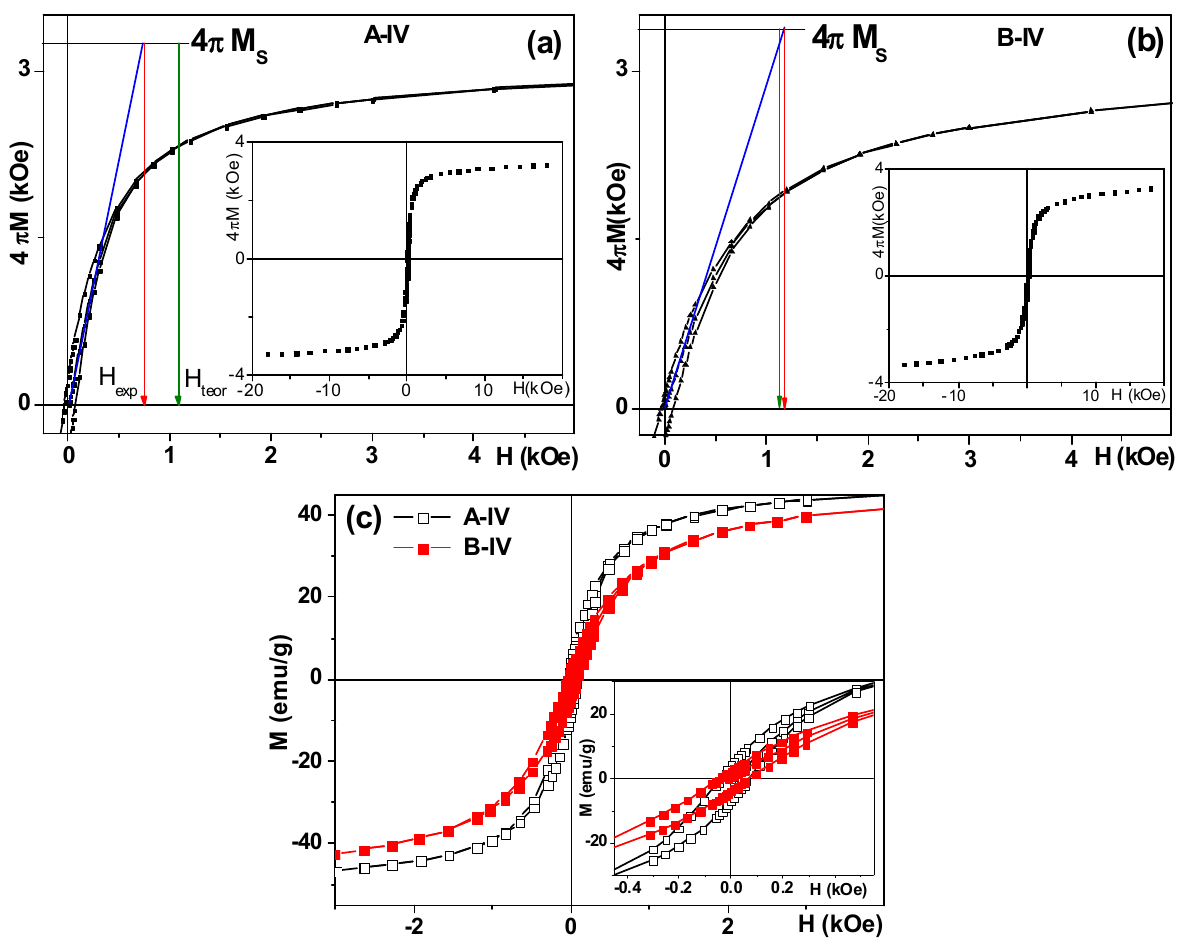
Figure 4. Hysteresis loops and primary magnetization curves of A-IV ( a ) and B-IV ( b ) samples. Insets for ( a ) and ( b ) show hysteresis loops of the same nanoparticles measured at room temperature up to higher field. Hysteresis loops (magnetization recalculated for emu/g) for A-IV and B-IV in small field clearly indicating a non-zero coercivity ( c ).